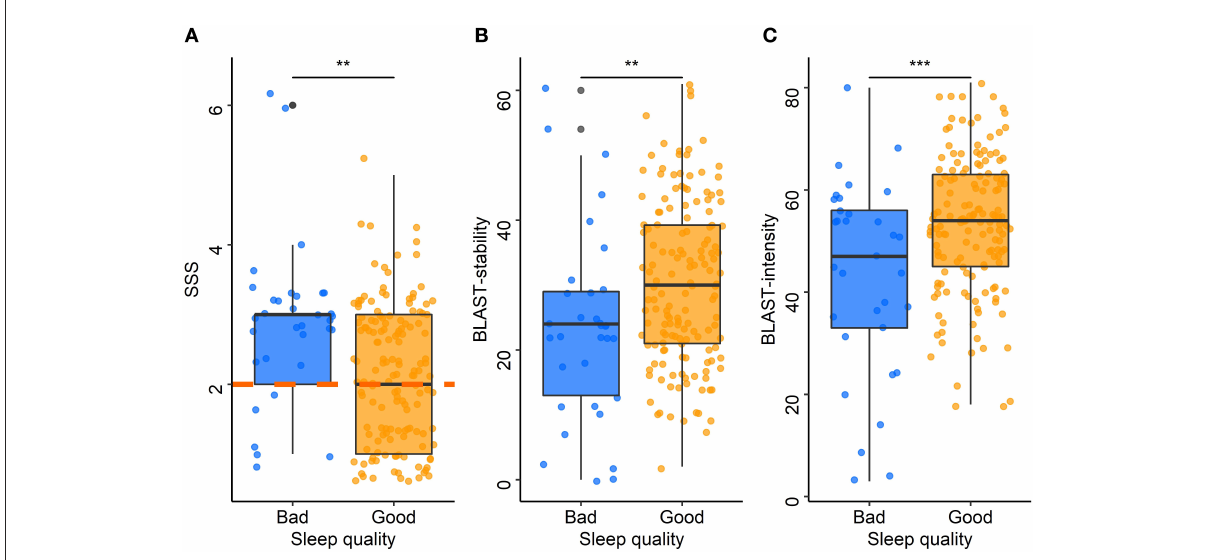
FIGURE5 Acute sleepiness, BLAST-stability, and BLAST-intensity according to sleep quality. Each point represents the median Stanford Sleepiness Scale score (A) , BLAST-stability (B) , and BLAST-intensity (C) for each driver according to the sleep quality the night before travel (blue: bad, orange: good). The central line of boxplots corresponds to the median of each score, the upper and lower parts correspond to the first and third quartiles. The orange dashed line (A) represents the pathological threshold of the SSS. Difference between groups is represented by stars: ***: p ≤ 0.001; **: p ≤ 0.01.